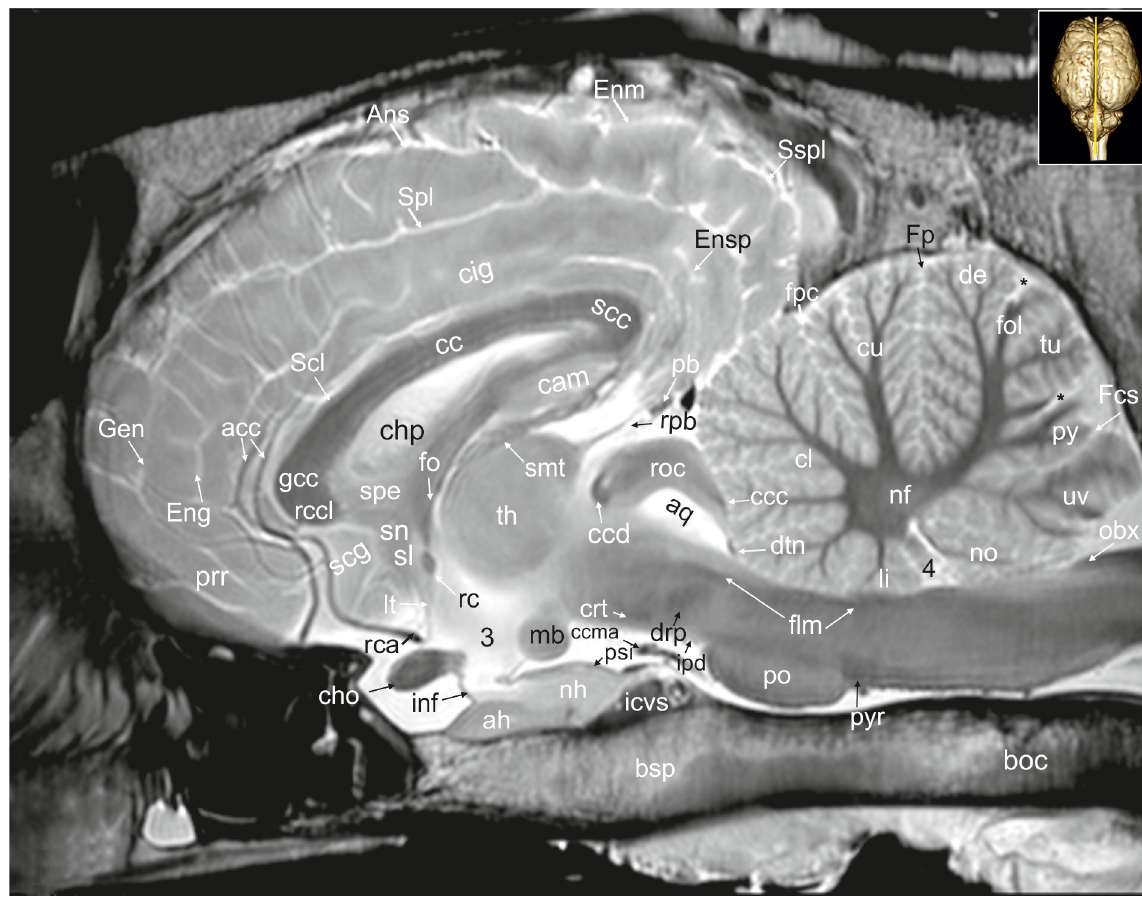
Fig 26. Mid-sagittal magnetic resonance image of the equine brain. acc: corpus callosum artery, ah: adenohypophysis, Ans: ansate sulcus, aq: mesencephalic aqueduct, boc: basioccipital bone, bsp: basisphenoidal bone, cam: ammon’s horn, cc: corpus callosum, ccc: commissure of the caudal colliculus, ccd: caudal commissure, ccma: caudal communicating artery, cho: optic chiasm, chp: choroid plexus, cig: cingulate gyrus, cin: cingulum, cl: central lobule, crt: rubro-cerebello-thalamic tract, cu: culmen, de: declive of the vermis, drp: decussation of the rostral cerebellar peduncles, dtn: decussation of trochlear nerve, Eng: endogenual sulcus, Enm: endomarginal sulcus, Espl: ectosplenial sulcus, flm: medial longitudinal fasciculus, fo: fornix, fol: folium of the vermis, Fp: primary fissure, Fpc: praeculminate fissure, gcc: genu of the corpus callosum, Gen: genual sulcus, icvs: intercavernous sinus, inf: infundibular stalk, ipd: interpeduncular nucleus, li: lingula of the vermis, lt: terminal lamina, mb: mamillary body, nf: fastigial nucleus, nh: neurohypophysis, no: nodulus of the vermis, obx: obex, pb: pineal body, po: pons, prr: prorean gyrus, psi: pars intermedia of the pituitary gland, py: pyramis of the vermis, pyr: pyramidal tract, rc: rostral commissure, rca: rostral cerebral artery, rcc: radiation of corpus callosum, rccl: rostrum of the corpus callosum, rpb: recess of the pineal body, roc: rostral colliculus, scc: